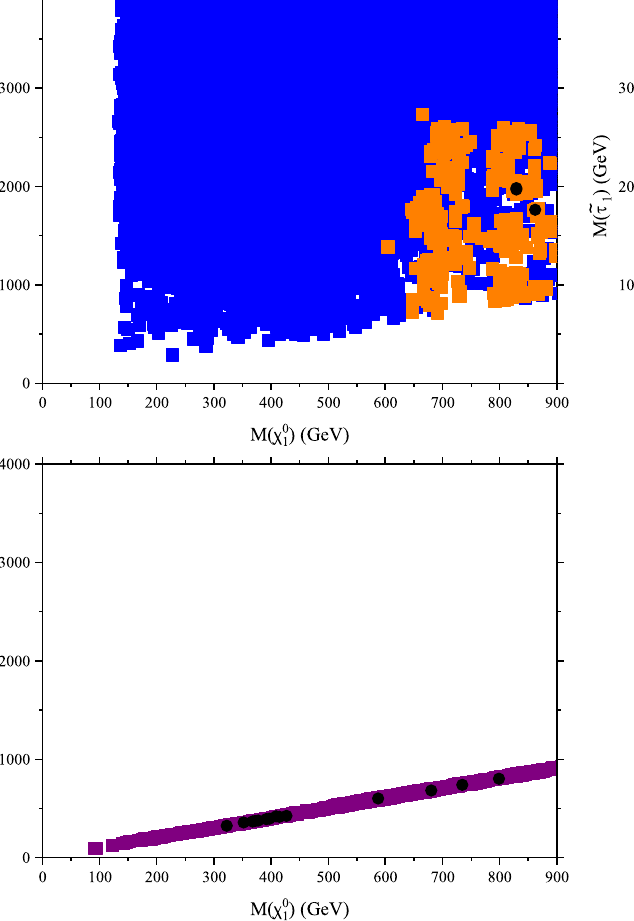
Fig. 2 Light stau mass M ( (cid:2) τ 1 ) as a function of the lightest neutralino ) for the four regions of the model space we study in this mass M ( (cid:2) χ 0 1 work.Thestaucoannihilationstripcanbeobservedinthelowerleftplot space. All points plot satisfy the light Higgs boson mass and relic den-